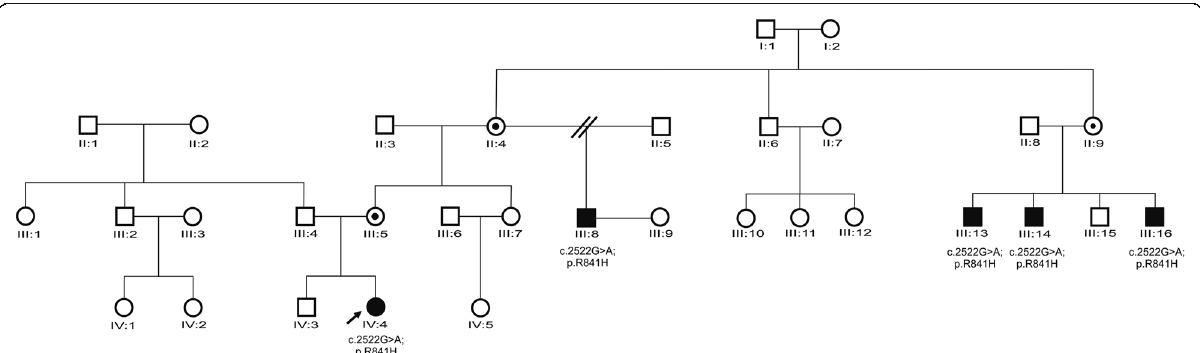
Fig. 2 Pedigree of the family 1. The proband is indicated by an arrow. Black-filled symbols represent affected individuals; open symbols represents unaffected individuals; black spots represents carrier individuals; squares: males; circle: